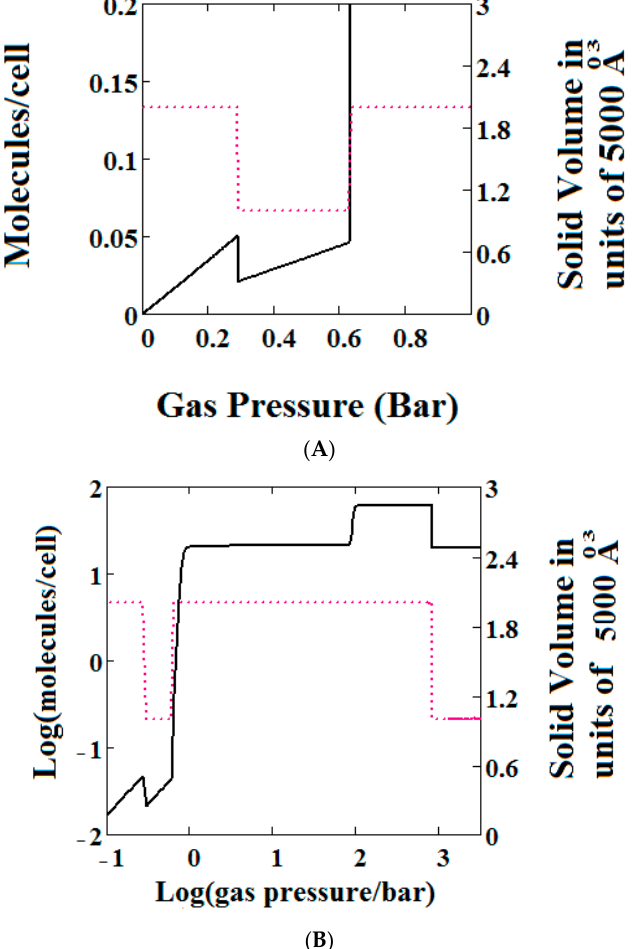
Figure 3. ( A ) Methane adsorption in the theory MOF showing Negative gas adsorption (NGA). The dotted red curve on the secondary right axis indicates the (narrow pore/large pore) NP/LP state of the MOF. The other parameters are T = 257 K, uglp = − 14.8 kJ/mole, ugnp = − 13.55 kJ/mole, J = − 1.08 kJ/mole, X = 5000 Å 3 , Y = 10,000Å 3 , ∆ = 0.025 kJ/mole, Nm = 40, scale = 0, nmaxlp = 21, nmaxnpb = 20; ( B ) same methane adsorption in the theory MOF on a Log ‐ Log scale showing 2 regions of NGA.